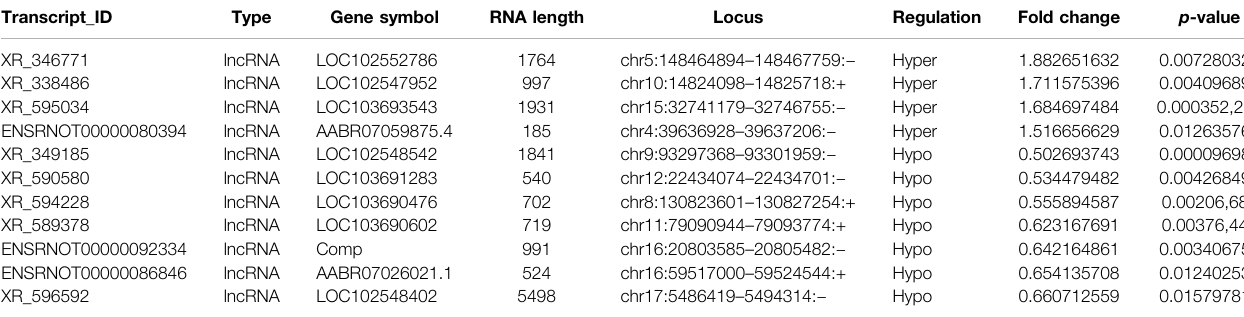
TABLE 1 | The detailed information of the hyper-methylated and hypo-methylated